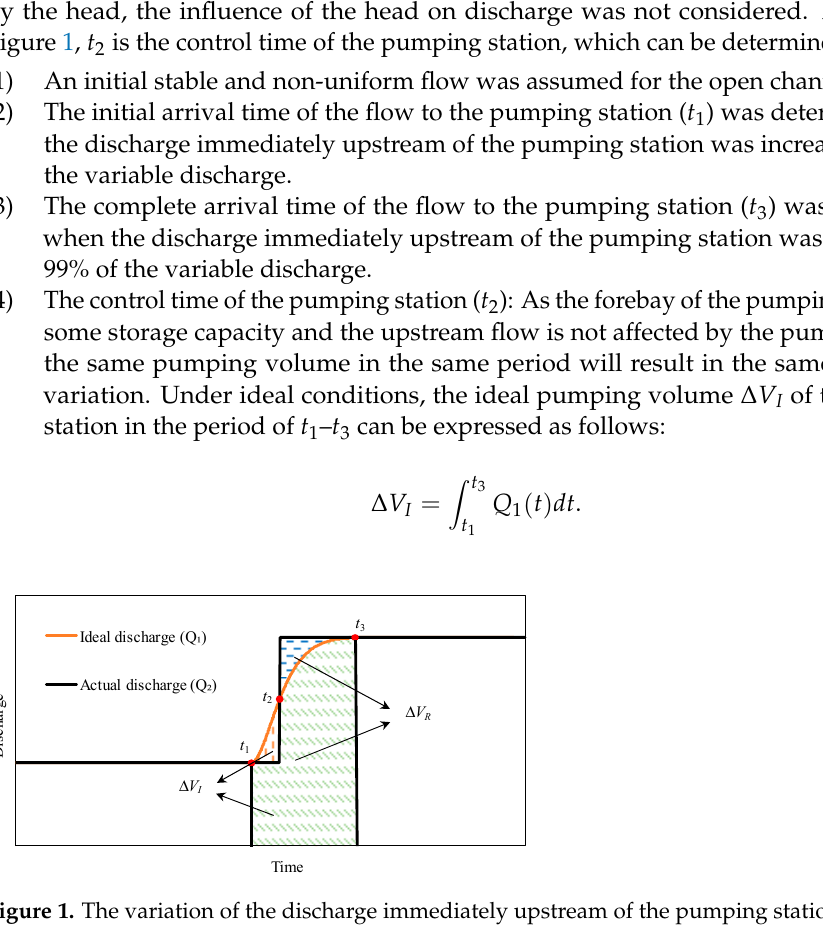
Figure 1. The variation of the discharge immediately upstream of the pumping station.